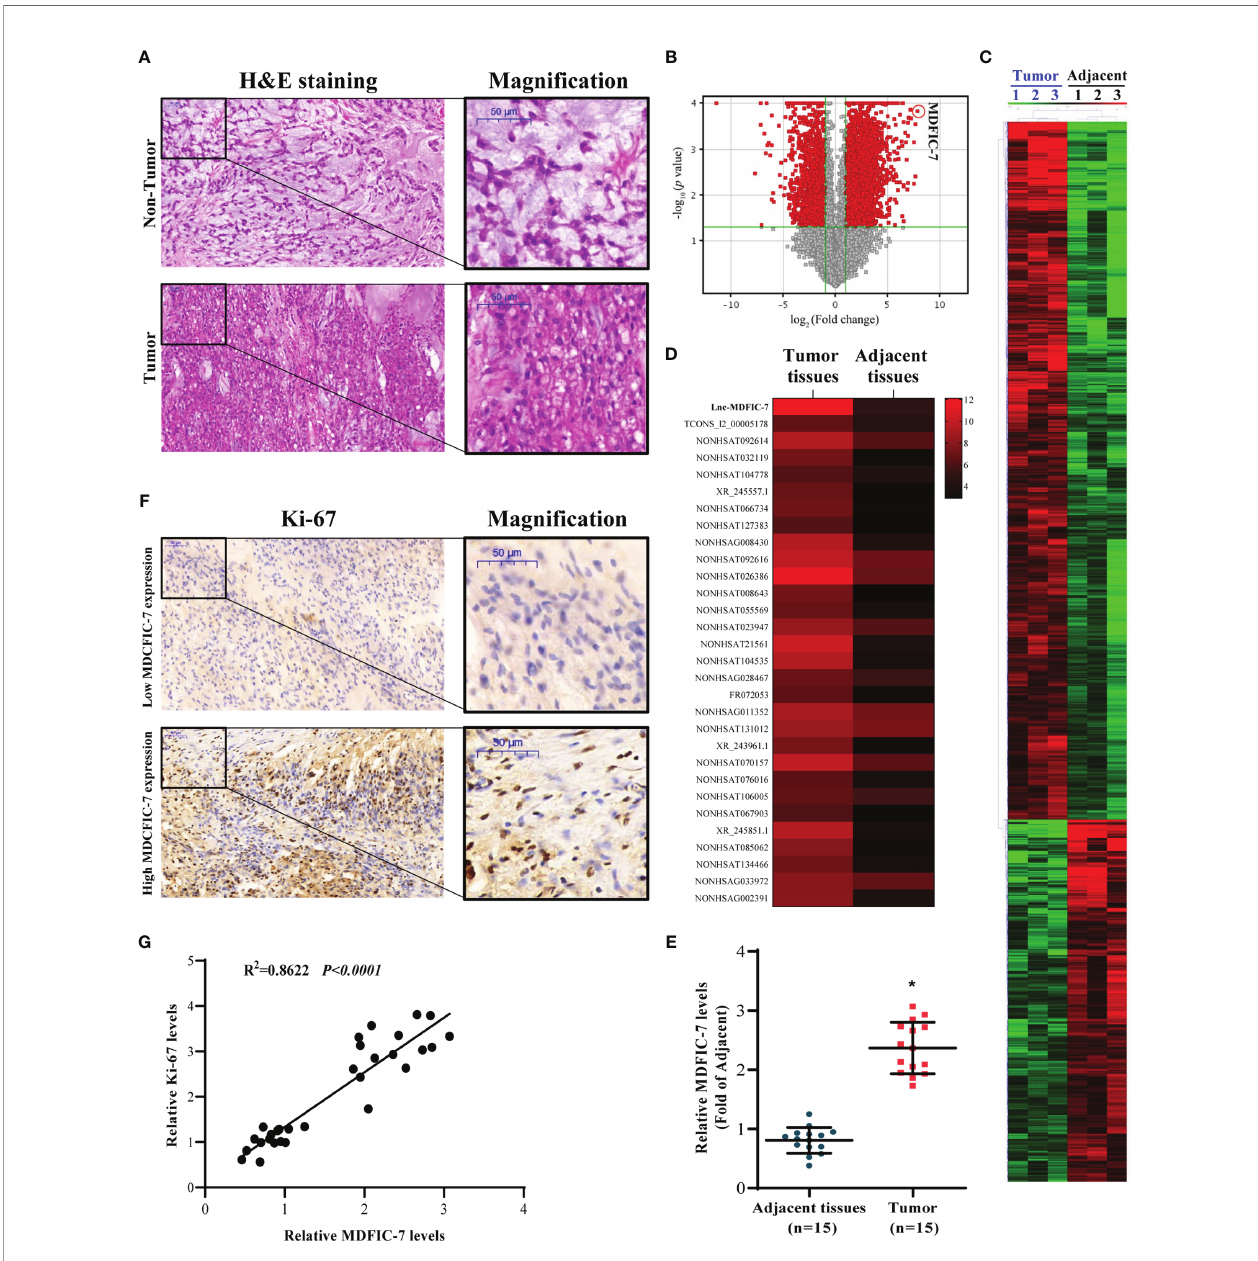
FIGURE 1 | LncRNA MDFIC-7 expression is upregulated in tumor tissues of chordoma. (A) H&E staining of clinical chordoma tumor tissues and adjacent non-tumor tissues. (B) Volcano plot illustrating fold-change in expression (log 2 fold change) against statistical signi fi cance (-log 10 adjusted P values) for all lncRNAs in tumor tissues vs . adjacent non-tumor tissues from three randomly selected chordoma patients. Red dots represent differentially expressed lncRNAs. (C) A total of 4900 differentially expressed lncRNAs are presented in the heatmap (tumor tissues vs . adjacent normal tissues). (D) Heat map of the expression of the top 30 upregulated lncRNAs in tumor tissues vs . adjacent normal tissues (red and black bars represent up- and down-regulation, respectively). (E) qRT-PCR analysis of lncRNA MDFIC- 7 expression in tumor tissues and adjacent non-tumor tissues. * p < 0.05 vs . adjacent tissues. (F) Immunohistochemistry of Ki-67 in tumor tissue and adjacent non- tumor tissue from chordoma patients. (G) Correlation analysis between lncRNA MDFIC-7 and Ki-67 expression in tumor tissues and adjacent non-tumor tissues of chordoma